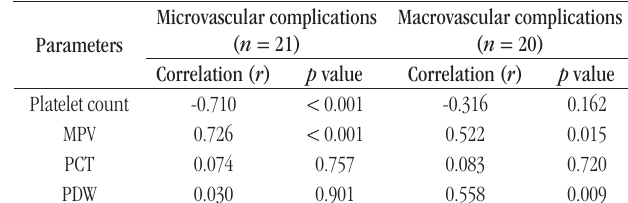
taBLE 2 – Pearson correlation for the association between platelet parameters and fasting blood glucose Parameters